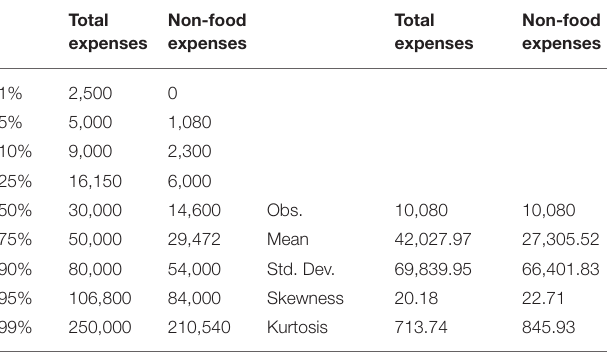
TABLE 2 | Household cumulative total expenses and non-food expenses (2014).